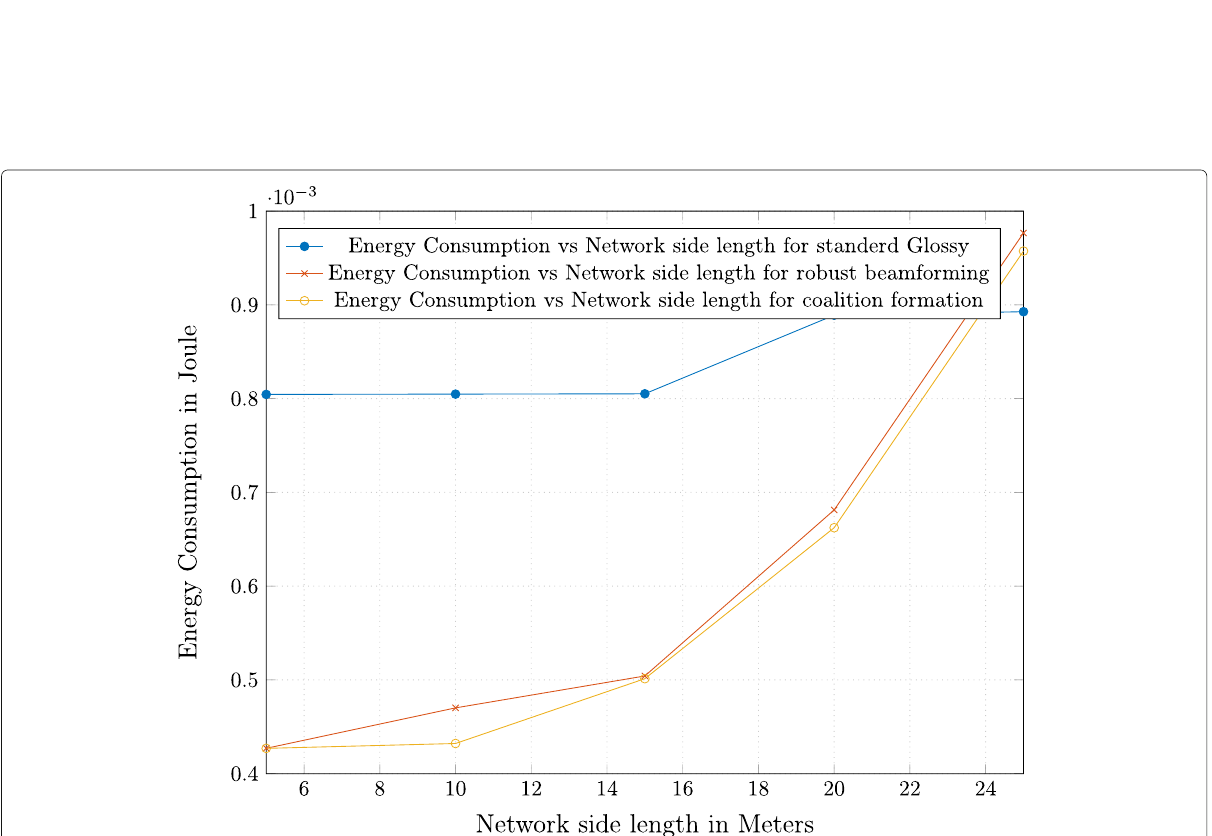
Fig. 9 Energy consumption. Energy consumption in Joule evaluated at different network side lengths for standard Glossy, robust beamforming, and robust beamforming with coalition